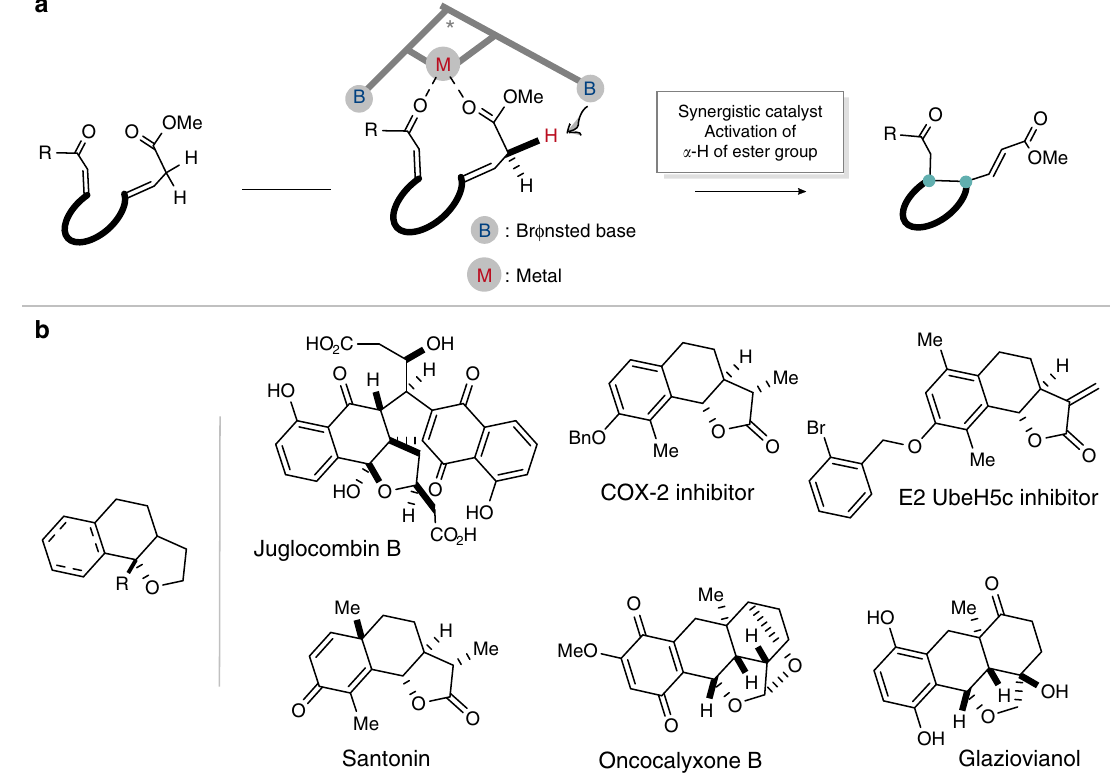
Fig. 1 Reaction design and related compounds containing the key [6.6.5]-tricyclic skeletons. a Synergistic catalytic strategy for the direct intramolecular asymmetric vinylogous Michael reaction. b Related natural products and pharmaceutically active compounds containing the tricyclic